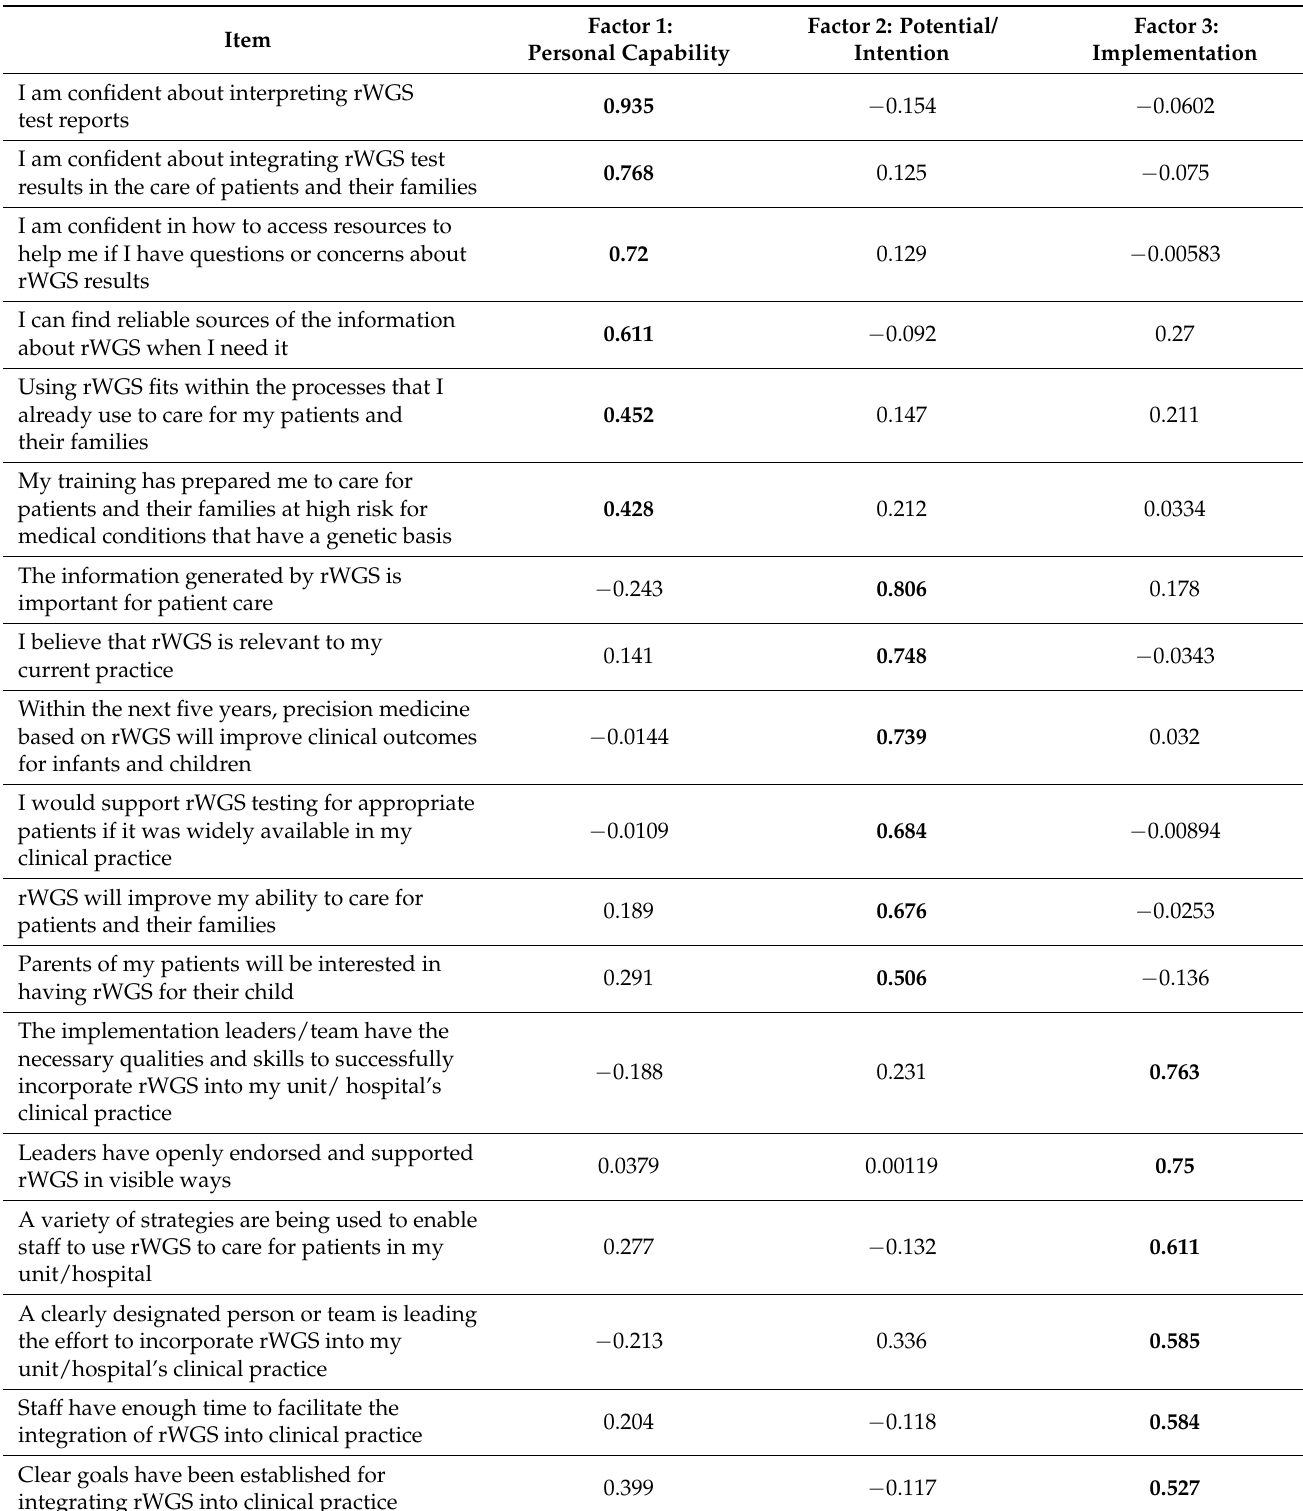
Table 3. Factor loadings based on a principal components analysis with oblimin rotation for 18 items regarding rWGS